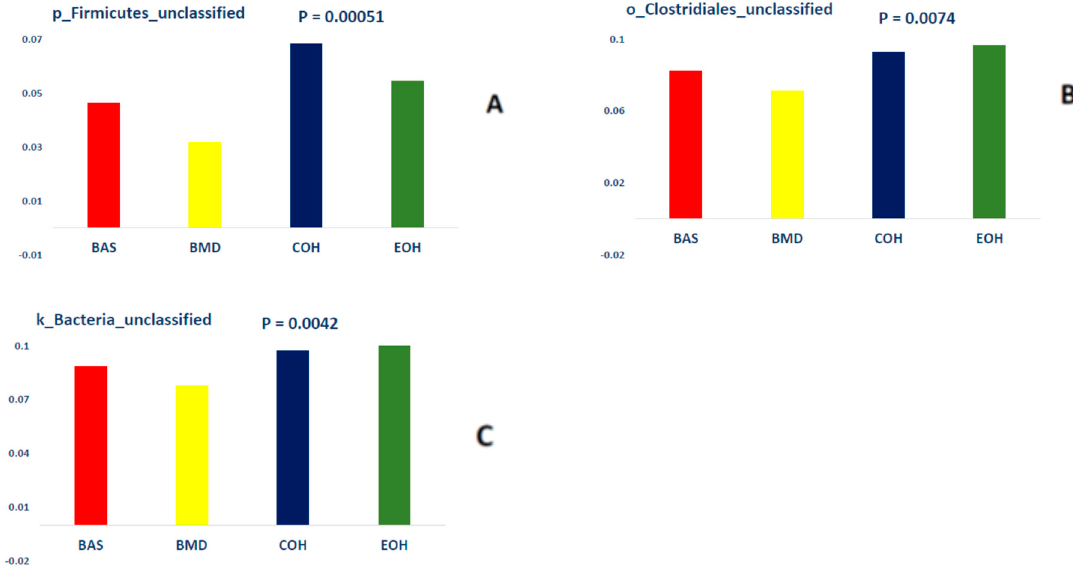
Figure 7. Illustration of the explanatory taxa for p_Firmicutes ( A ), o_Clostridilaes ( B ), and k_Bacteria_unclassified ( C ). BAS = basal diet; BMD = antibiotic diet; COH = diet supplemented with 3% coarse oat hulls; and EOH = diet supplemented with 3% extruded oat hulls.